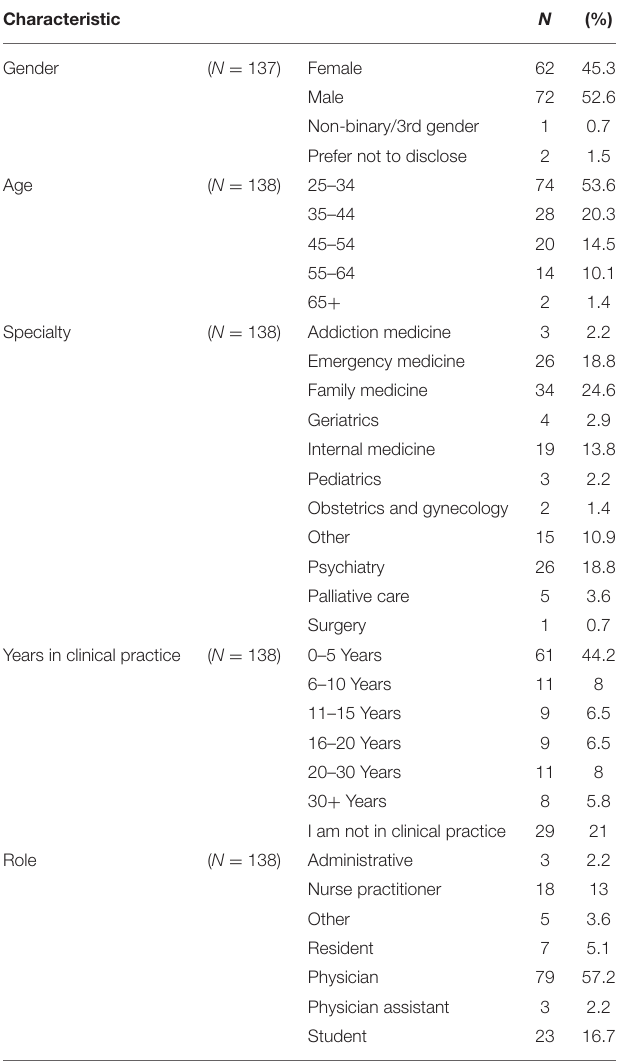
TABLE 2 | Demographic and clinical